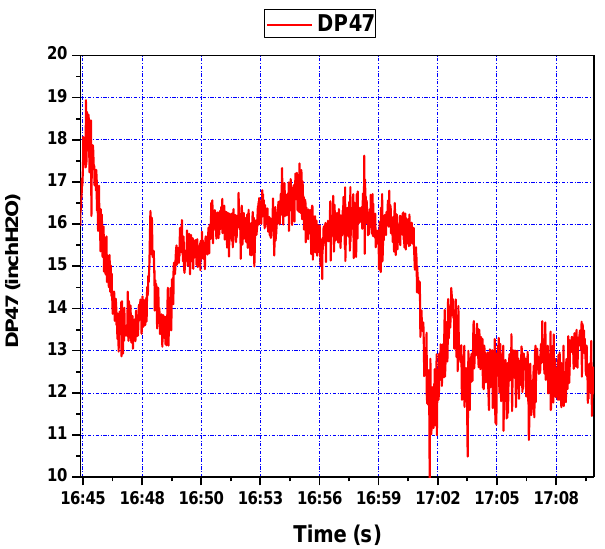
Figure 16. Pressure difference response of riser (DP47) during step setpoint changes.